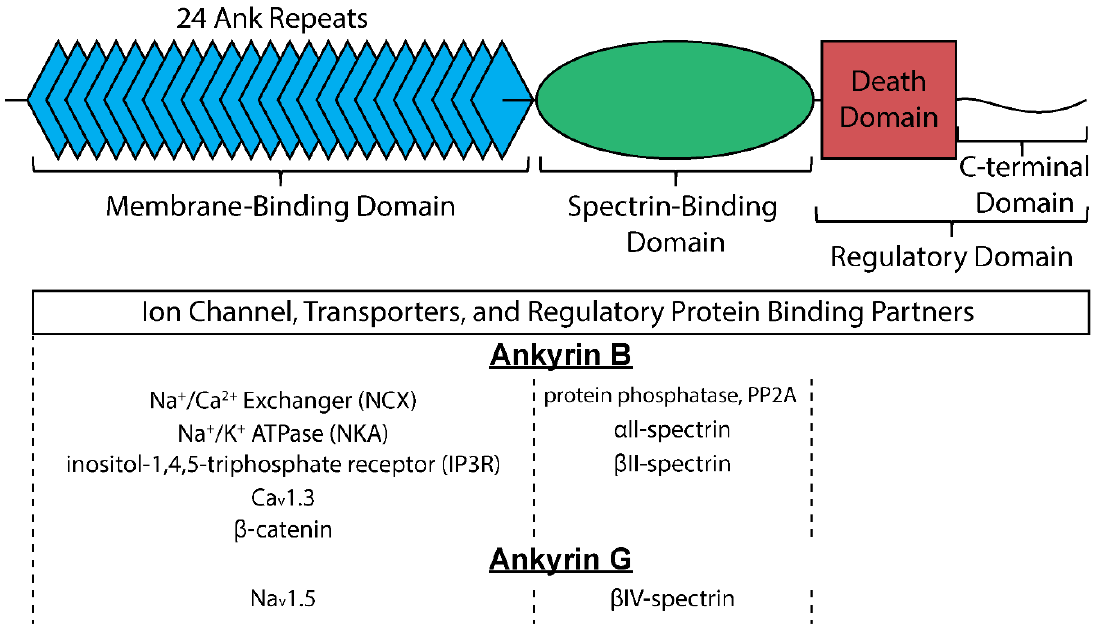
Figure 2. Structure of canonical ankyrin and major interacting proteins organized by site of interaction for ankyrin-B and ankyrin-G.